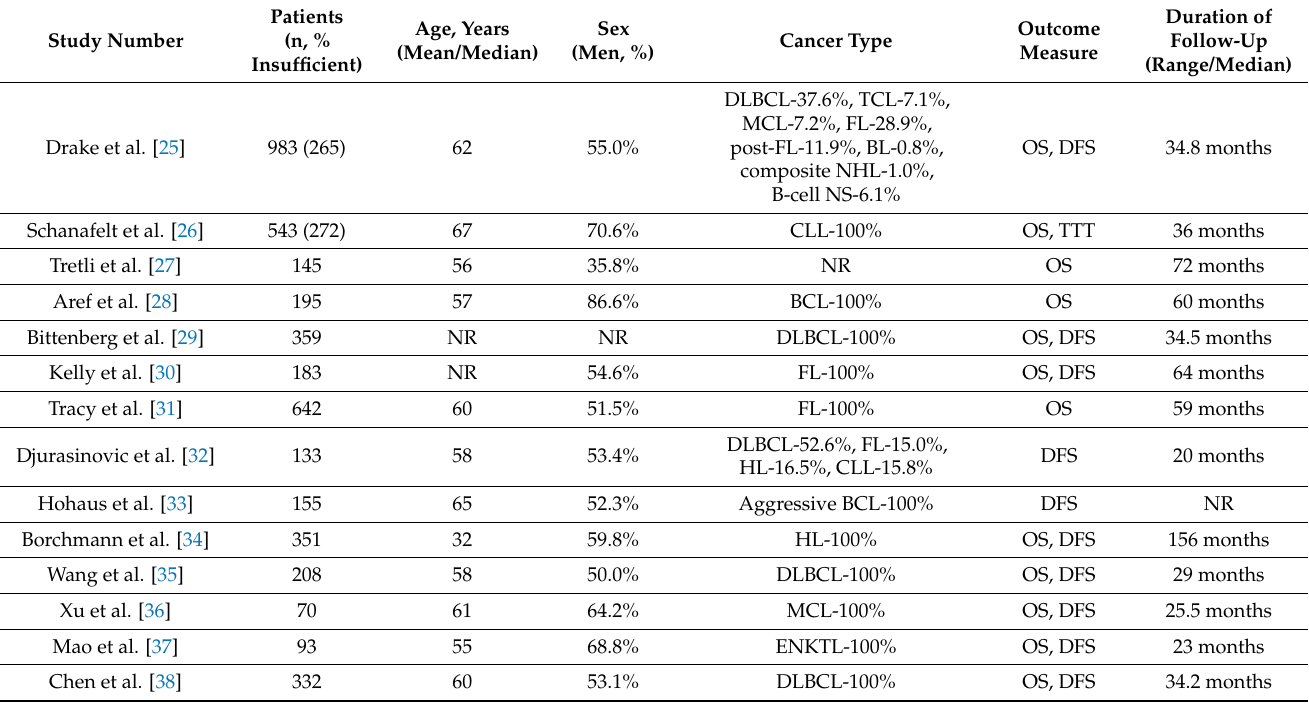
Table 2. Summary of findings in the included